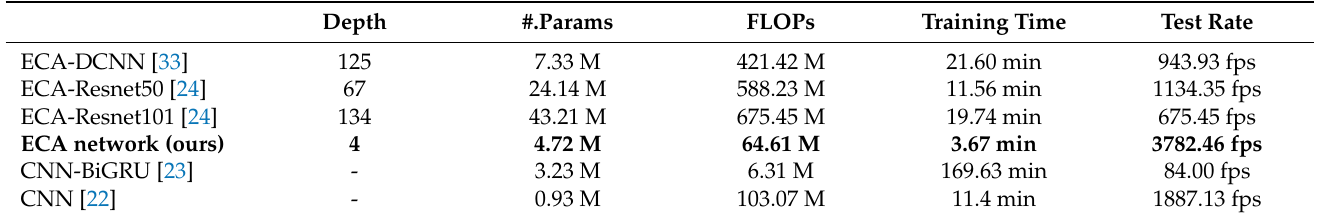
Table 3. Comparison of different models in terms of network depth, network parameters (#.Params), floating point operations per second (FLOPs), training time, and processing speed on test data (test rate).